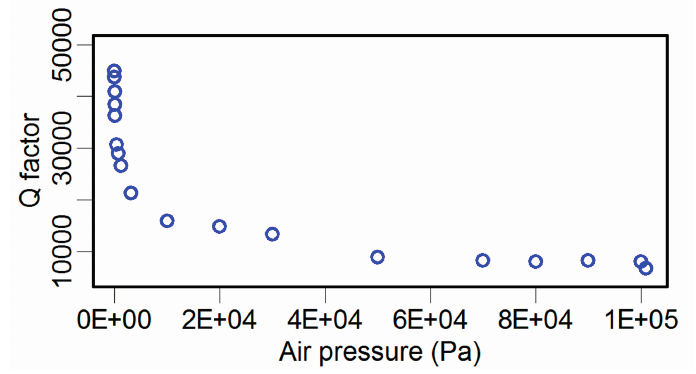
Figure 5. Atmosphere pressure vs. the resonance frequency of the TF.